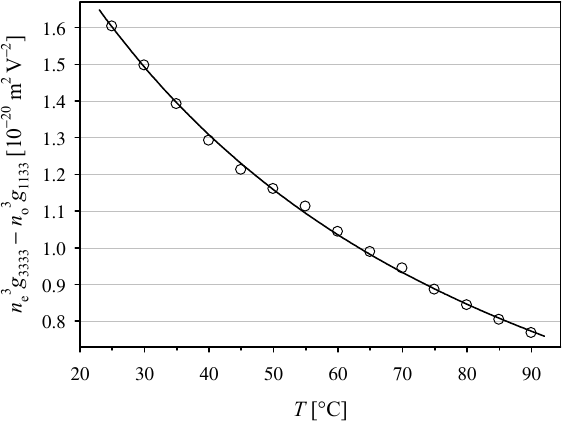
− n 3 Figure 4. Temperature dependence of the quadratic electro-optic coefficient n 3 e g o g 1133 3333 [10 − 20 m 2 V − 2 ] = 2.139 − 0.02492 T + 0.000109 T 2 for T given in [ ◦ C]. − 1 ) 2 , we could arrive at ( ε g 1133 by ε 2 g 3333 − n 3 If we divide the coefficient n 3 33 e o 0 − n 3 n 3 f f . However, it seems more advantageous to consider the temperature e o 1133 3333 n − 3 f 1133 , where n 3 n − 3 dependence of f ef = f 3333 − n 3 takes values close to 1 and changes o e o e only slightly from 1.0852 to 1.0835 in the temperature range from 25 to 90 ◦ C [27]. Similarly, (cid:0) − 1 (cid:1) 2 (cid:0) n 2 − 1 (cid:1) − 2 δ n 2 tive intrinsic coefficient δ ef = δ 3333 − n e n − 1 1133 . The absolute o o e